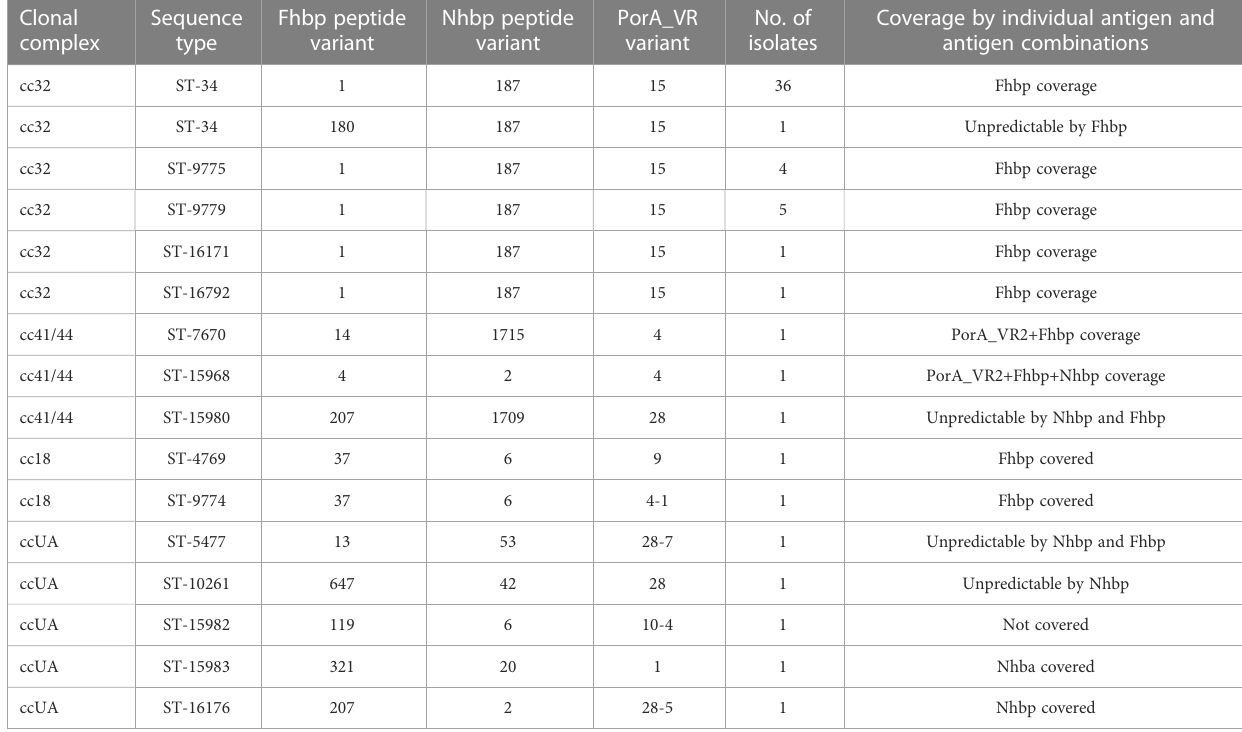
TABLE 4 The coverage of MenB isolates predicted by